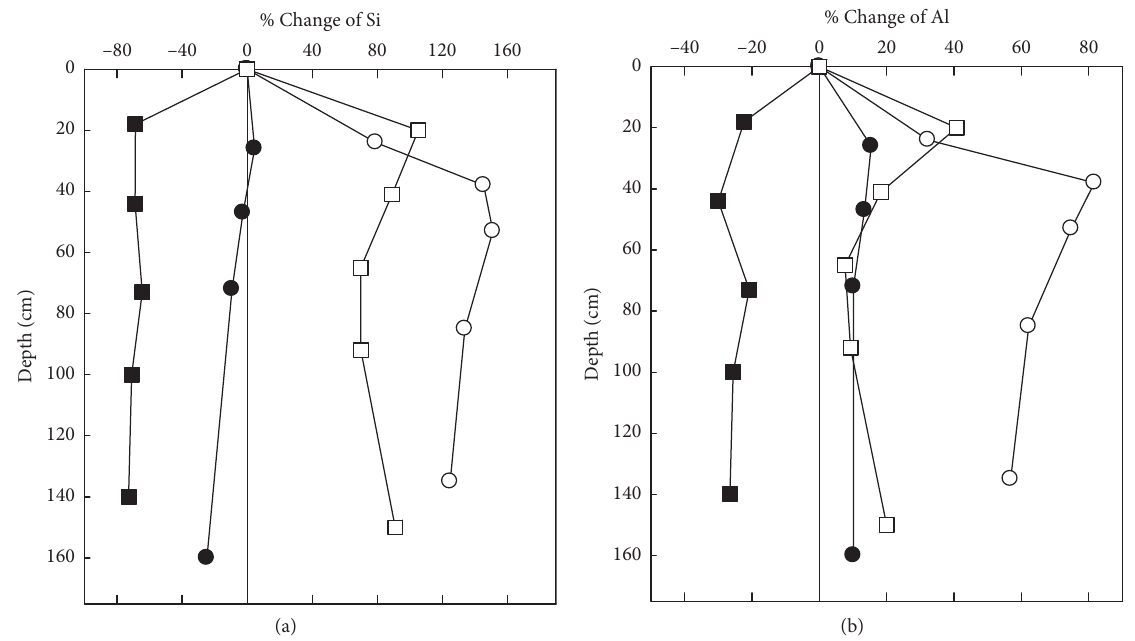
Figure 4: Depth profiles of the percentage change of Si and Al for the soil series of Pyeongdae ( ■ ), Namwon ( ● ), Jeju ( □ ), and Gangjeong ( ○ ) calculated using Zr as the immobile